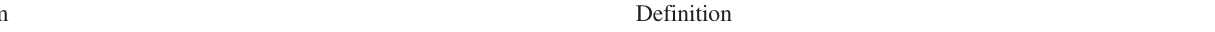
TABLE V. Glossary of network terms relevant to this paper. Term